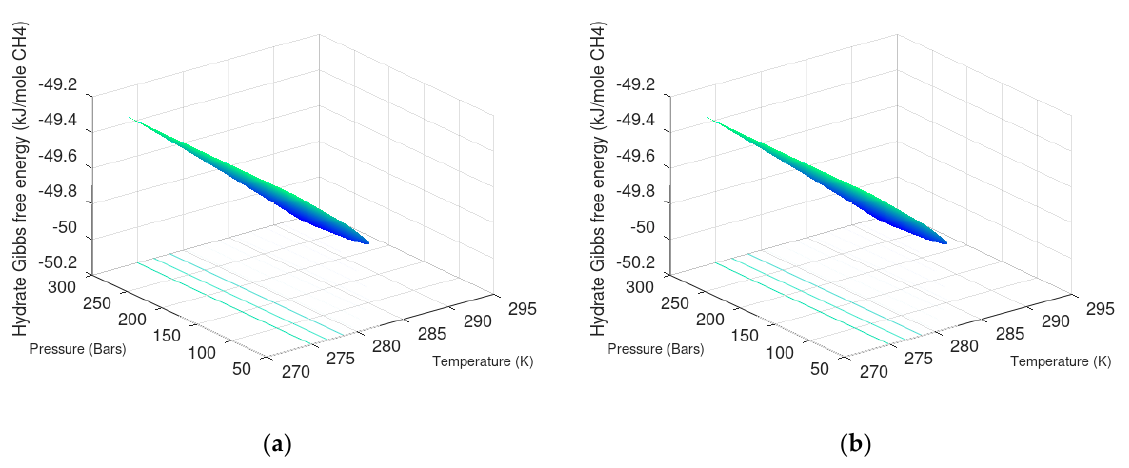
Figure 11. Gibbs free energy for homogeneously formed CH 4 hydrate as function of temperature pressure and mole-fractions CH 4 (see Figure 10) for: ( a ) 0 ethanol and ( b ) 3 mole percent ethanol in water.